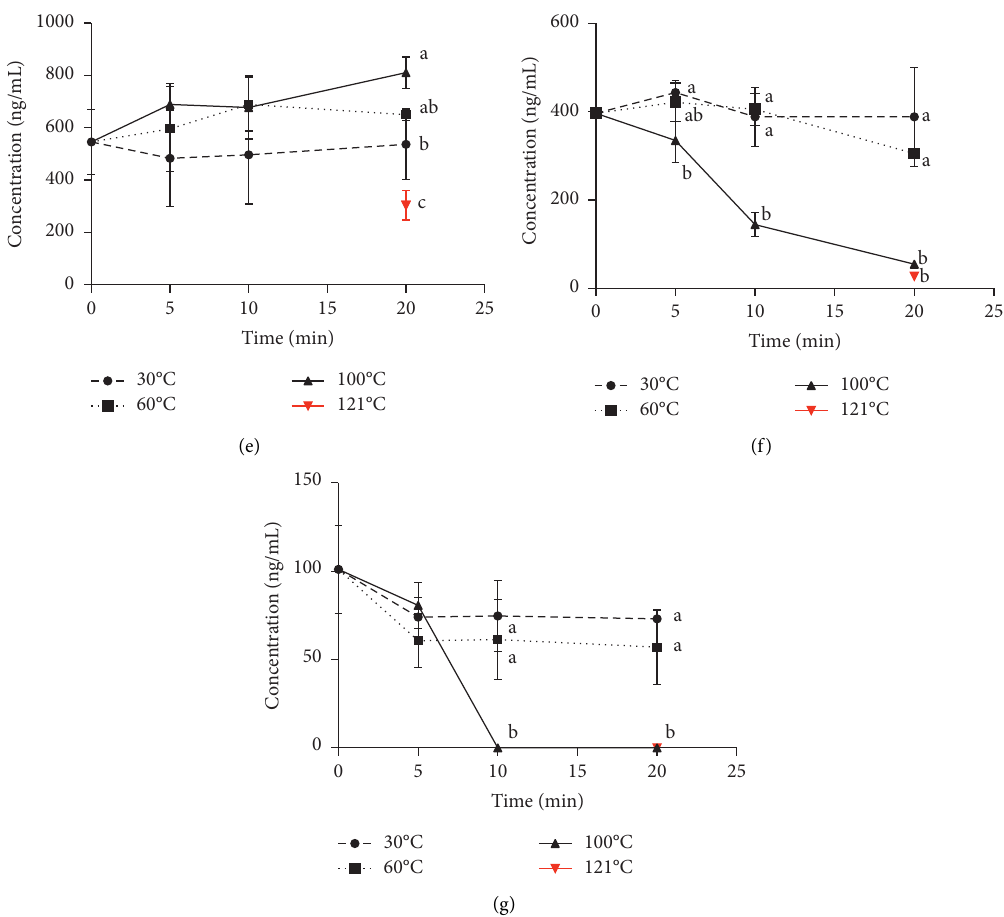
Figure 2: The effect of thermal processing on the contents of bitter gourd saponins. Bitter gourd extracts were treated at 30 ° C (filled circle), 60 ° C (filled square), 100 ° C (filled triangle), or 121 ° C (inverted triangle). (a) momordicoside L, (b) momordicoside K, (c) momordicoside I, (d) momordicoside F 1 , (e) momordicoside F 2 , (f) 3, 7, 25-trihydroxycucurbita-5,23(E)-dien-19-al, and (g) momordicine I were analysed by UPLC-ESI-MS/MS. Different letters represent significant differences. The error bars represent the standard deviation ( n �